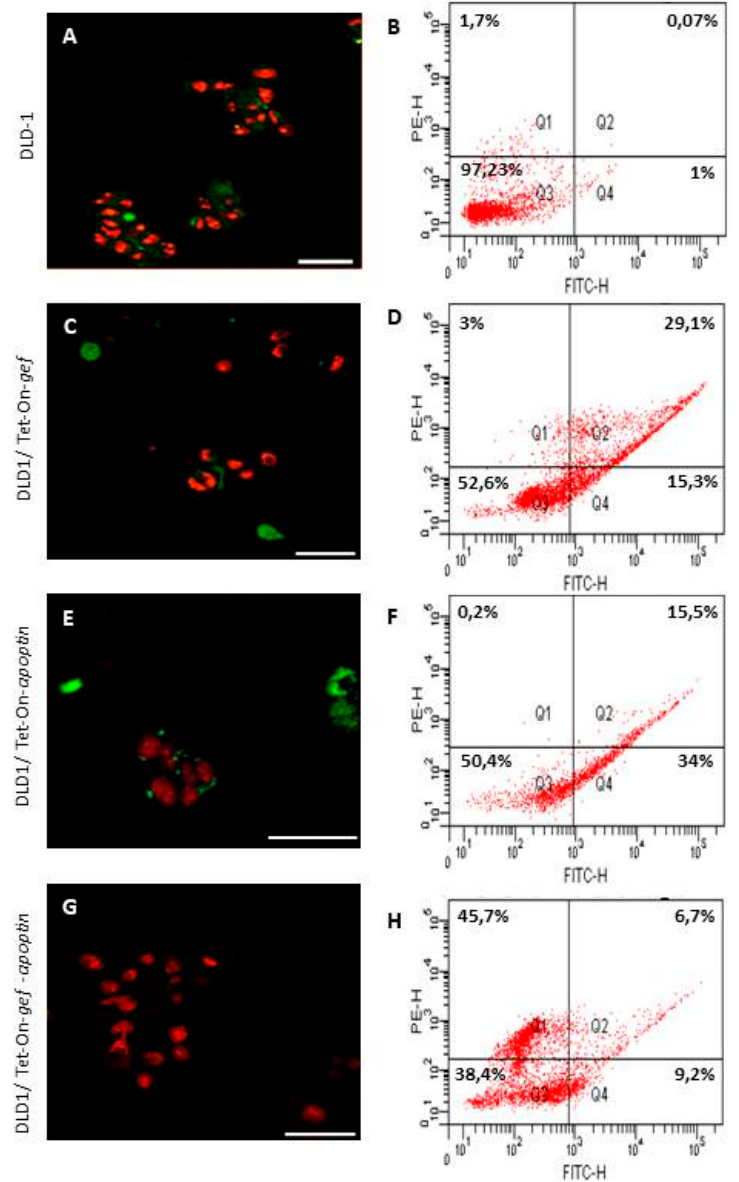
Figure 4. Confocal analysis and cell sorting quantification of DLD-1 ( A , B ), DLD1/Tet-On- gef ( C , D ), DLD1/Tet-On- apoptin ( E , F ), and DLD1/Tet-On- gef - apoptin ( G , H ) cells (Scale bar = 50 µ m). Cells were stained with annexin V-FITC and PI. Early apoptosis (Q4: green stain for annexin-FITC), late apoptosis (Q2: green stain for annexin-FITC in combination with red stain for PI), and necrosis (Q1: red stain for PI) can be observed; viable cells are not visible (Q3). In DLD1 expressing gef or apoptin, cells in early and late apoptosis are observed ( C , E ). DLD1/Tet-On- gef - apoptin cells showed a higher proportion of necrotic cells when compared to some early and late apoptotic cells ( G , H ). To identify the mechanism by which gef and/or apoptin genes induce cell death, caspases 3, 9 and 8, cytochrome c, bax, and p53 were studied. Protein collection was performed after 2 days of